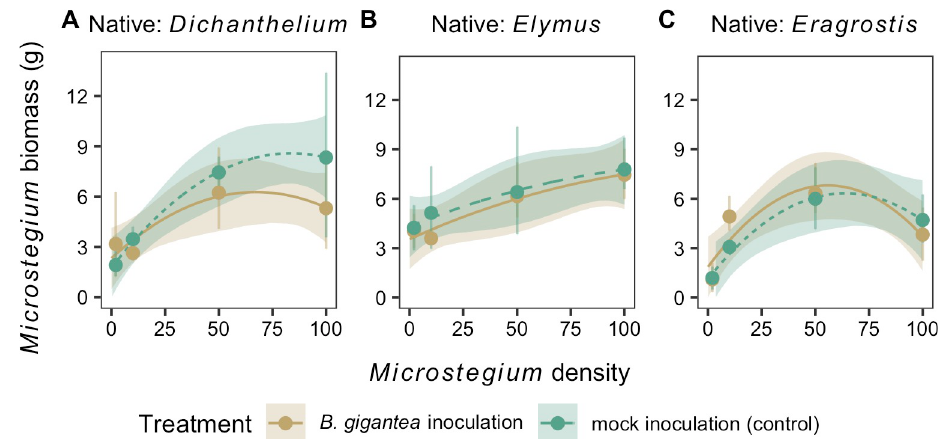
Fig 4. Microstegium biomass. The biomass of Microstegium following B . gigantea or mock inoculation across the Microstegium density gradient in the presence of (A) Dichanthelium , (B) Elymus , and (C) Eragrostis . Observations (points and error bars, mean ± 95% confidence intervals) and model fits (lines and shaded ribbons, mean ± 95% credible intervals) are shown.